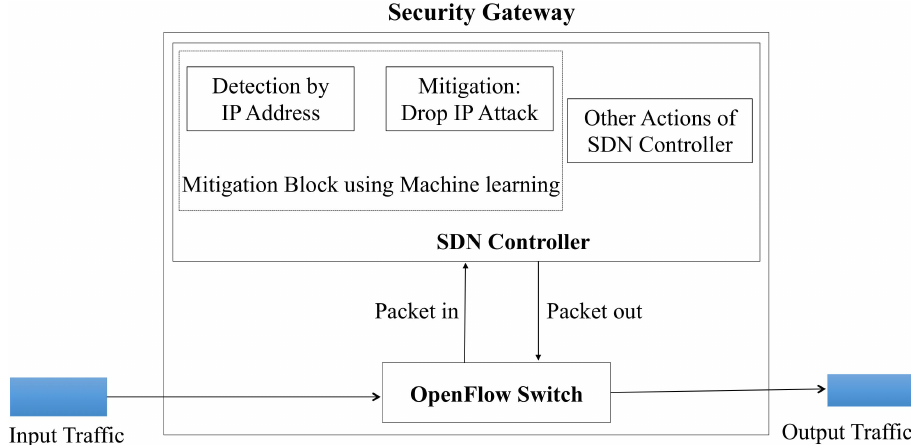
Figure 4. System